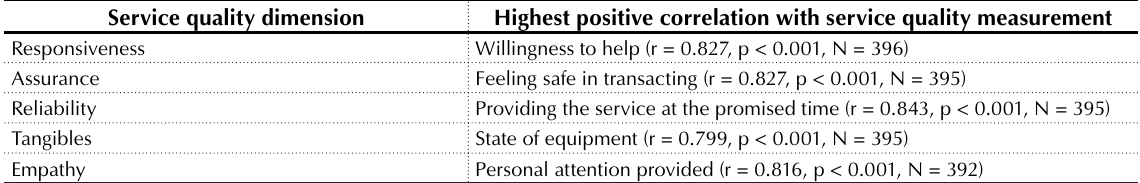
Table 6. Correlation between service quality dimensions and measurements Service quality dimension